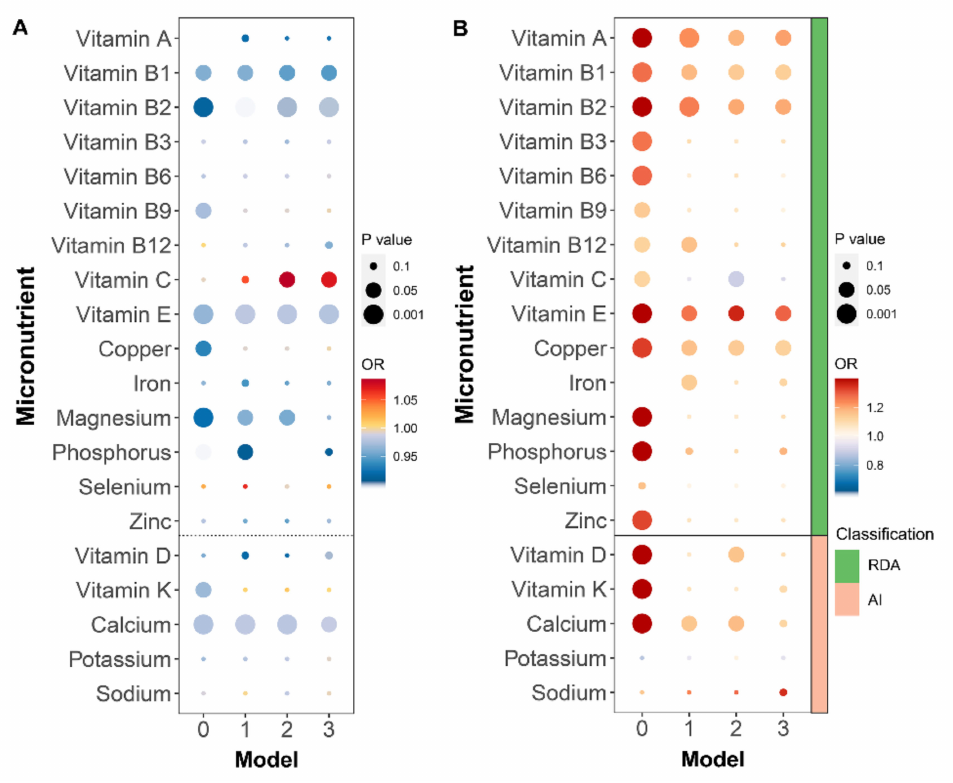
Figure 2. Logistic regression results for categorical and continuous variables for the four models: ( A ) logistic regression results of micronutrient intake (continuous variable); ( B ) logistic regression results of intake inadequate (categorical variable). RDA: recommended dietary allowance; AI: adequate intake. Model 0 had no adjustment of data; Model 1 was a multifactor logistic regression adjusted for all eleven covariates; Model 2 used propensity score matching to be balanced covariates (including smoke, alcohol, and physical activity) and then used multifactorial logistic regression adjusting for age, gender, educational level, income, BMI, diabetes, HPL, and HTN; Model 3 used PSM to balance all eleven